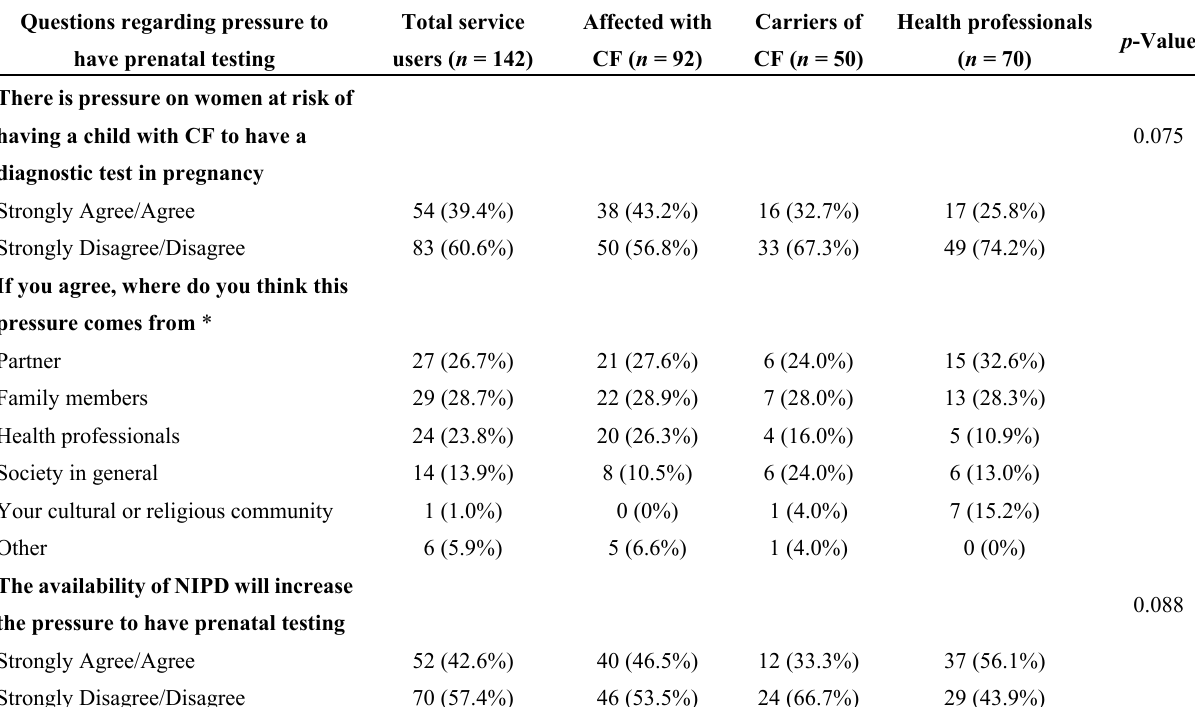
Table 5. Views on the pressure to have prenatal